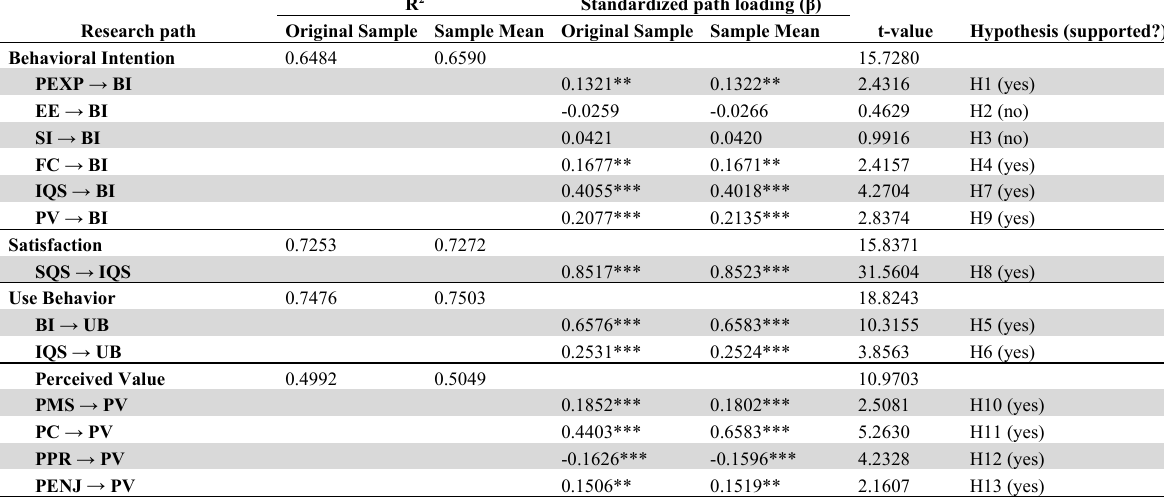
Summarized bootstrapping tests of path